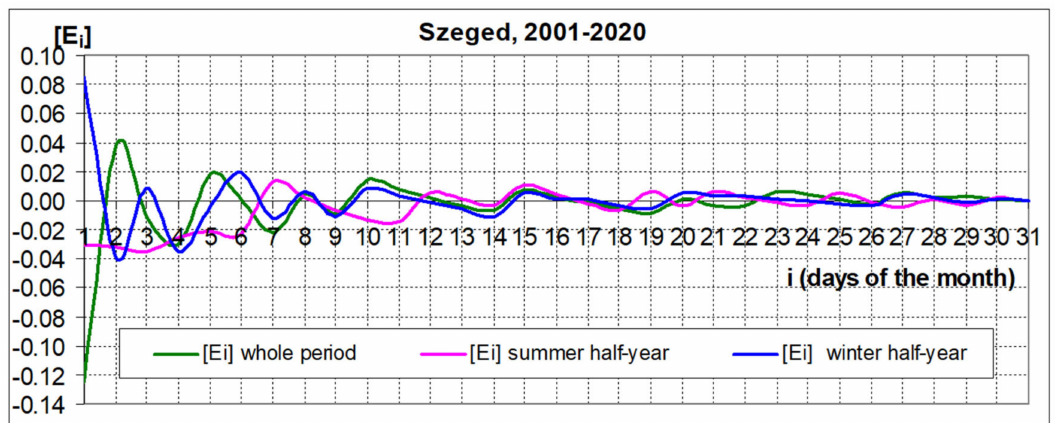
Figure 6. Monthly runs of average relative error. The monthly course of the ratio of the underestimation and overestimation (ue/oe) is shown in Figure 7 over the three periods. The figure shows the predominance of overestimations (ue/oe < 1) over the whole period, with a higher number in the first half of the month. Seasonally, however, this rate fell sharply in favor of overestimations, with a frequency of 90% in the summer and 77% in winter. The periodical averages of the ue/oe ratio were similar: 1.00 for the whole period, 1.28 for the summer semester and 1.17 for the winter semester. The averages for the 10 days selected did not differ significantly from these: 0.96, 1.33 and 1.11, respectively. An appreciable linear trend could be observed only in the winter semester in the ue/oe ratio. The slope of the trend was positive, 0.01, i.e., the ue/oe ratio increased by an average of 1% per day during the month, indicating an increase in the number of